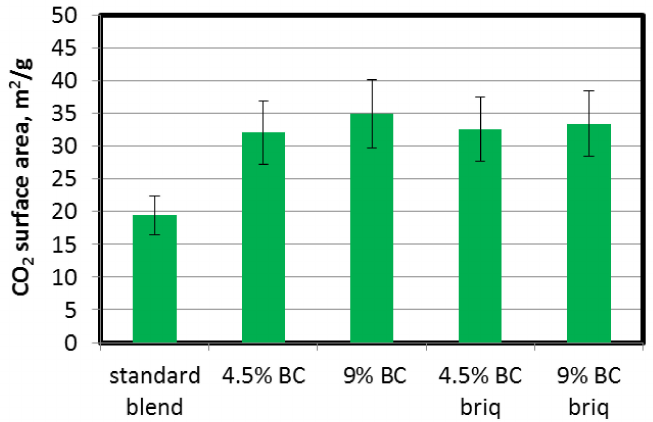
Figure 5. Influence of lignite addition on CO 2 surface area of